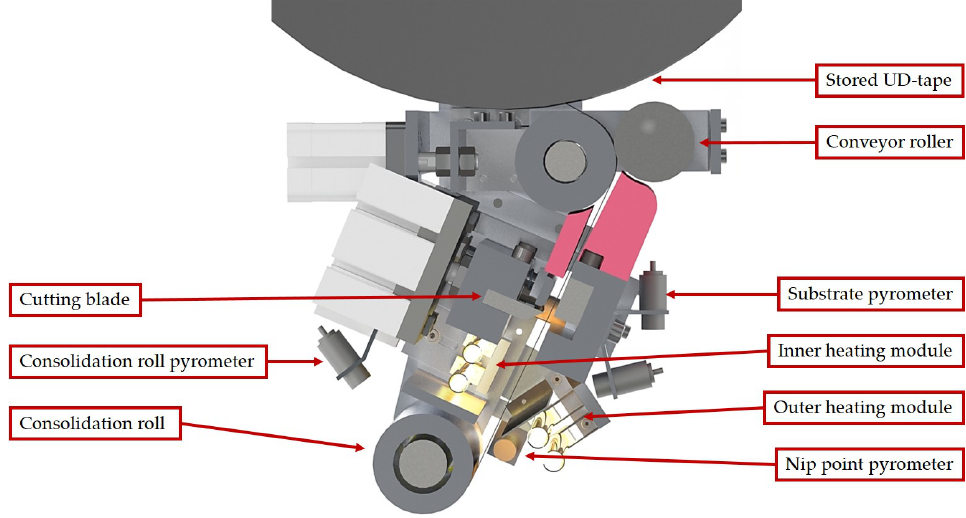
Figure 2. Sectional view of the tape layer and its functional